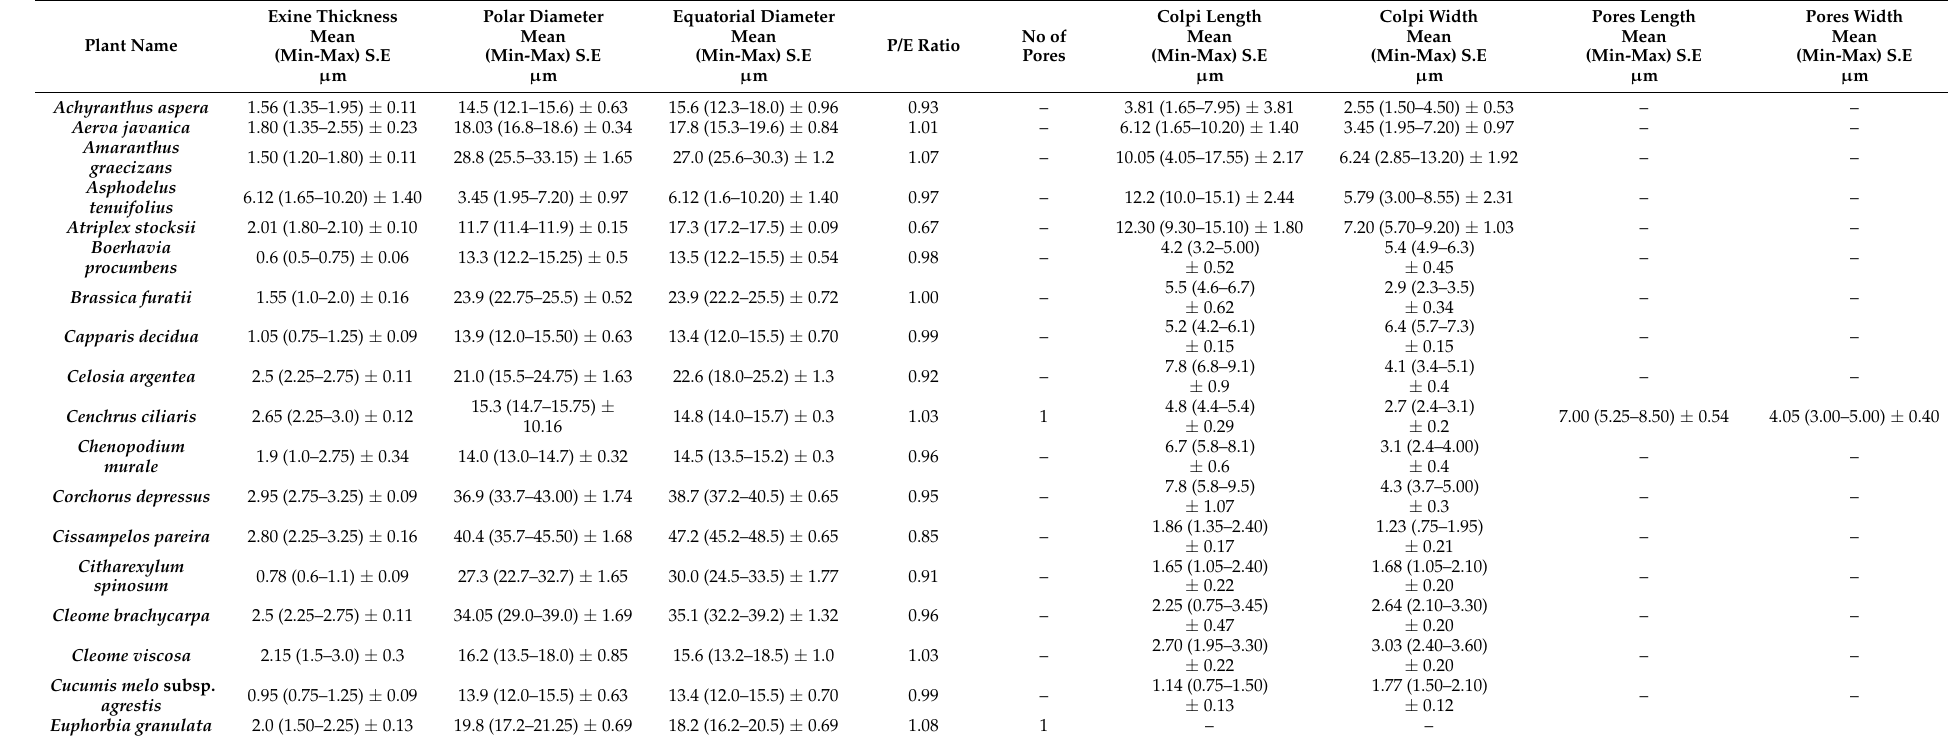
Table 3. Quantitative data of pollen of weeds members from Potohar region of